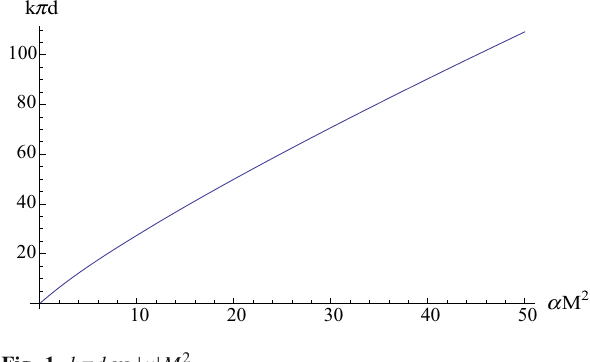
Fig. 1 k π d vs | α | M